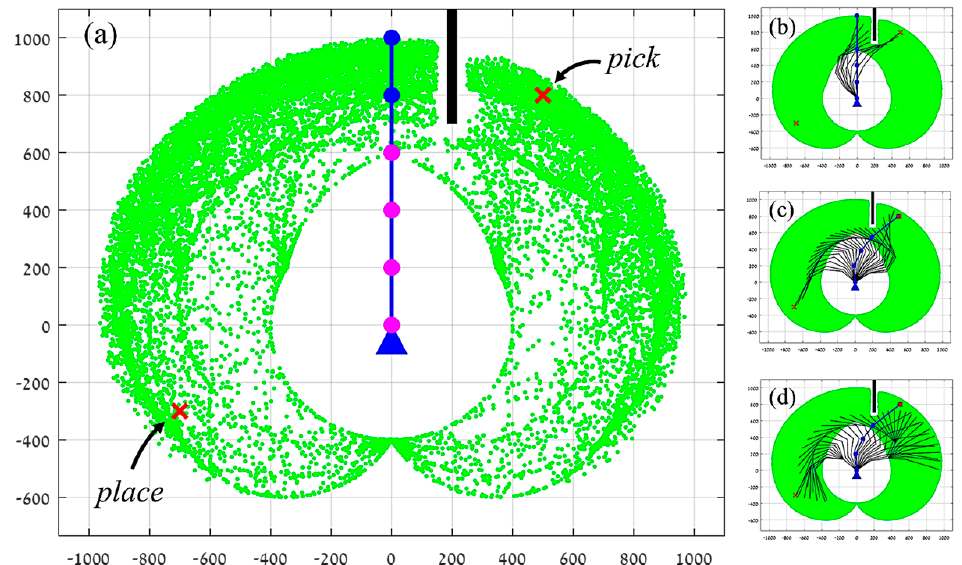
Figure 7. Simulation results for the pick and place task. ( a ) For the given targets, minimal redundancy only involves 4 out of 5 joints (in magenta). In ( b , d ), an optimal path was found for the target to pick ( b ) and place ( d ), using full areal coverage as the search graph for the A* search. The steps shown in black were downsized by half. ( c ) Shows the path from pick to place after modification for a minimally actuated arm.